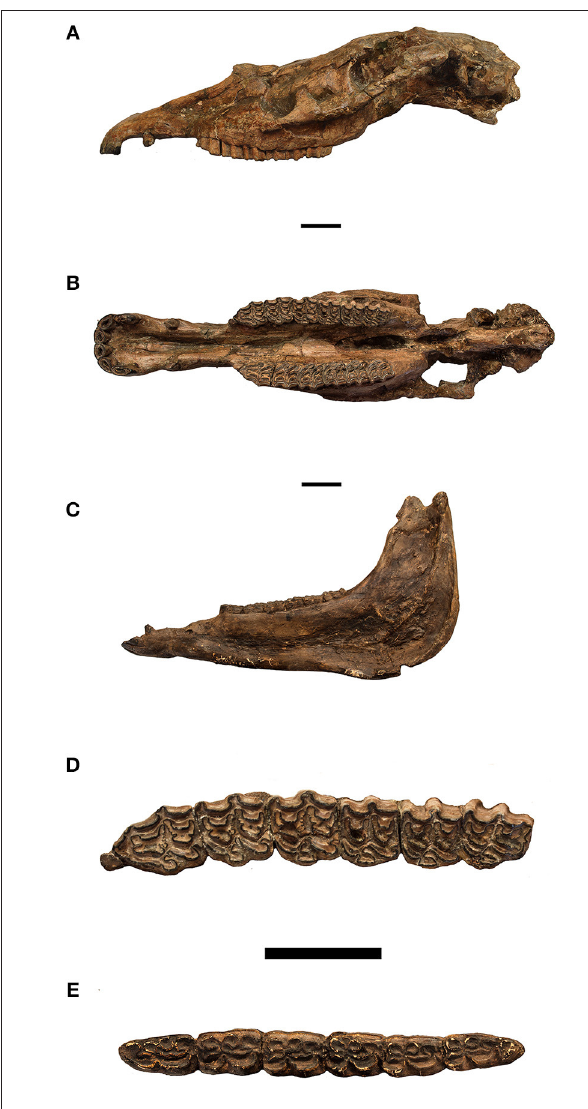
FIGURE 4 | Equus stenonis . (A) Skull in lateral view; (B) Skull in ventral view; (C) Mandible in lateral view; (D) Upper tooth row in occlusal view; (E) Lower tooth row in occlusal view.